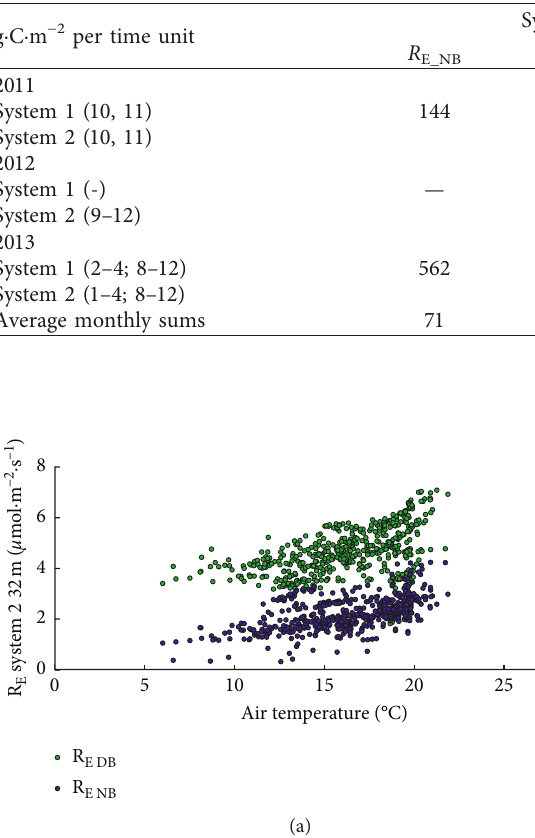
Figure 4: Median CO 2 mixing ratios in ppm at different heights. Table 2: Ecosystem respiration ( R E ) from the nighttime and the daytime partitioning models R E_NB and R E_DB , respectively. Monthly sums represent times when complete gap-filled data sets are available (available months indicated in brackets).